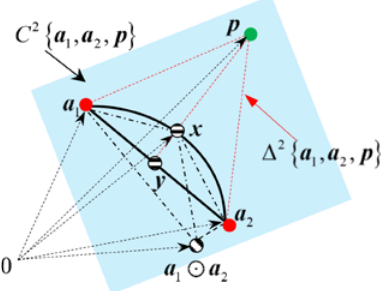
Figure 3. Geometric interpretation of Property 1. x is a BMM pixel, y is x ’s projection on the line of two endmembers a 1 and a 2 . If p lies on the line of x and its linear mixture component x LMM = a 1 s 1 + a 2 s 2 , y has the same abundances with respect to a 1 and a 2 as x [59–62] (i.e., y = x LMM ). The case can be extended to a high-dimensional space as well.